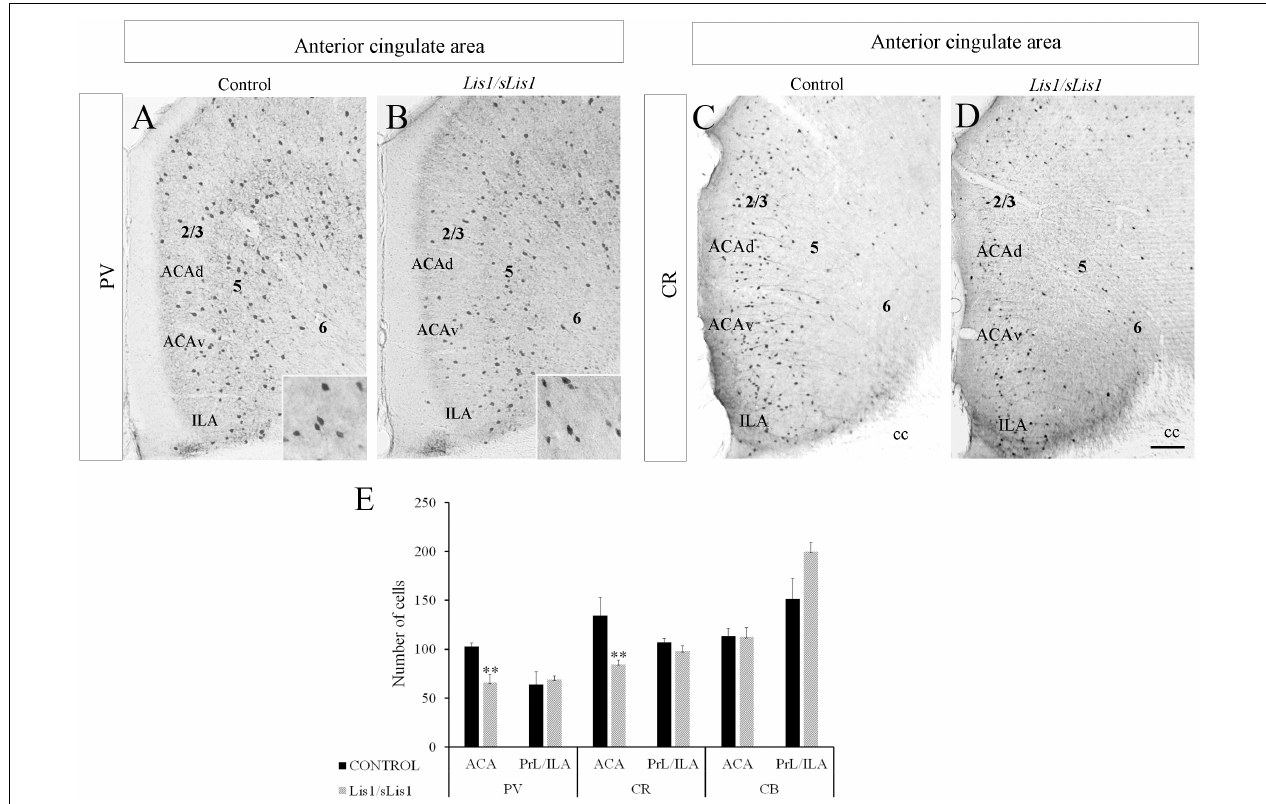
FIGURE 2 | Study of GABAergic interneurons in the anterior cingulate area in control and Lis1/sLis1 mutant mice in adults. (A–D) Photomicrographs of coronal sections taken through the anterior cingulate area and processed by immunoperoxidase staining for parvalbumin (PV) and calretinin (CR) using single immunostaining. There were fewer PV-positive cells in the anterior cingulate area of Lis1/sLis1 mice than the controls (A,B) . A higher magnification of PV+ cells is inserted in the bottom right. CR immunostaining demonstrates a decrease in CR-positive neurons in Lis1/sLis1 mice versus adult control littermates (C,D) . (E) Histogram indicating the average ± SE in WT and Lis1/sLis1 mutant mice of PV+ cells, CR+ cells and CB+ cells in the ACA and PrL/IL. For all panels the scale bar is 200 µ m. For inserts in (A,B) , scale bar is 50 µ